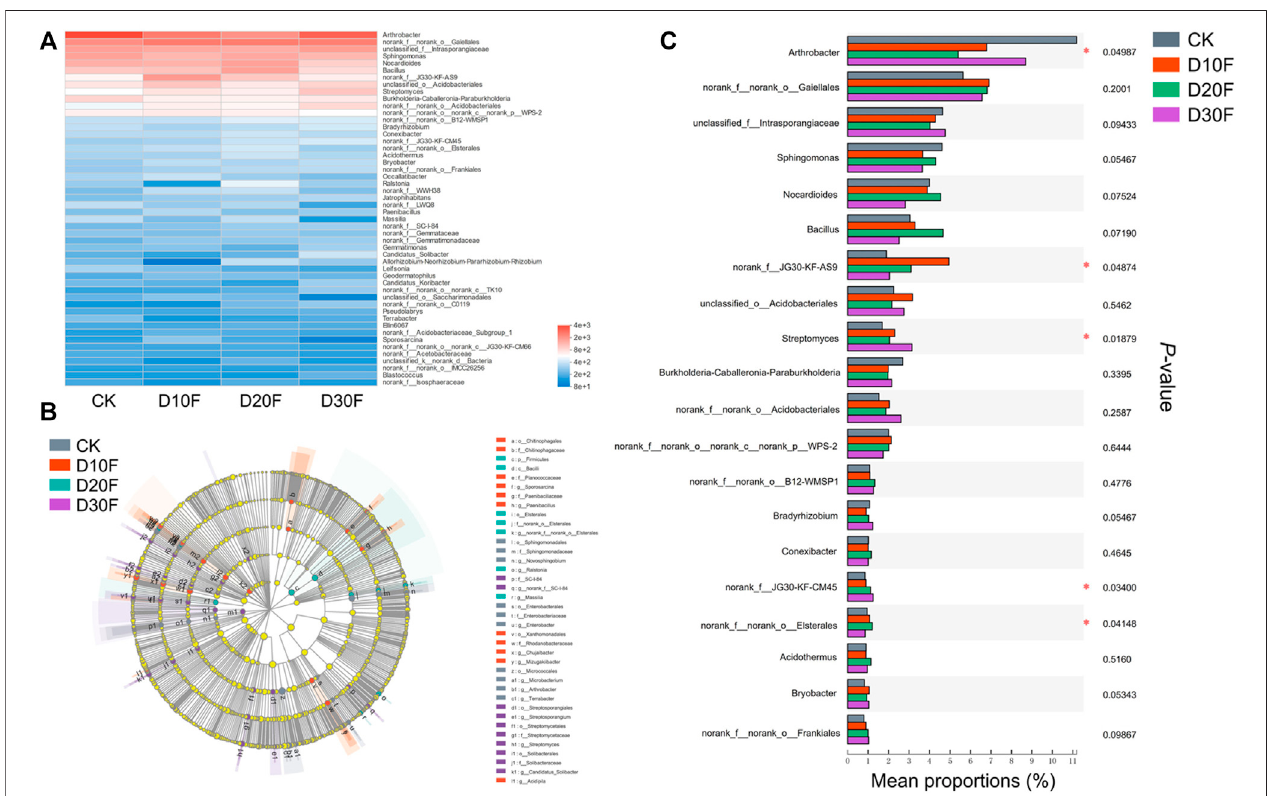
FIGURE 4 | Variation of the bacterial communities in different treatments based on genus. (A) Heatmap of the top 50 genera based on logarithmic statistics of identi fi edOTUsamongdifferenttreatments. (B) LDAEffectSize(LEfSe)analysisbasedonthegenusamongdifferenttreatments. (C) Barplotofrelativeabundanceofthe top 20 genera among different treatments based on the Kruskal-Wallis H